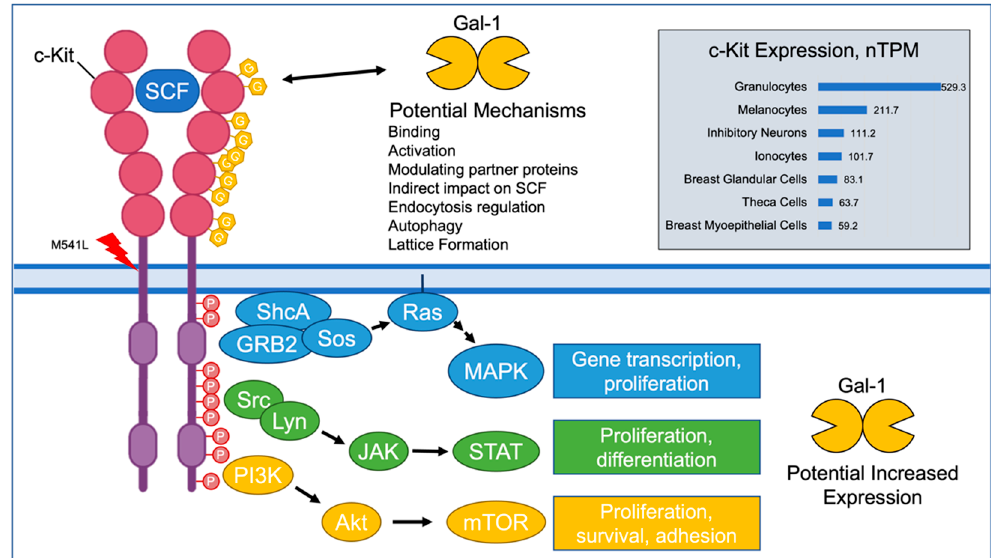
Figure 6. Potential Interactions between c-Kit and Galectin-1. c-Kit is expressed in immune cells, melanocytes, neurons, and breast tissue cells. Galectin-1 can bind to appropriate glycosylation sites on c-Kit with a variety of possible results affecting c-Kit functioning. The downstream effects of increased c-Kit activity could include increased transcription of galectin-1 levels. (SCF: stem cell factor; nTPM: normalized transcriptions per million; Gal-1: galectin-1) [10,104,108,109].